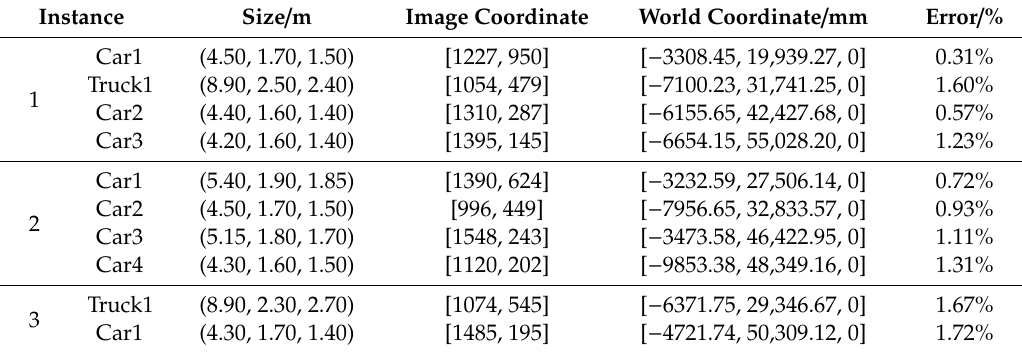
Table 5. Measurement of vehicle spatial distribution errors in dataset scene